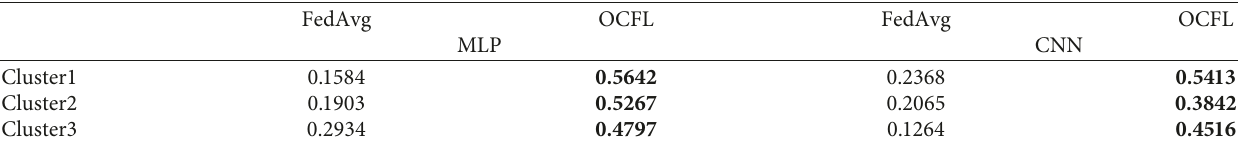
Figure 7: Cifar-10 data set clustering experiment (rounds � 500, η � 0.00001, frac � 0.1, (E) � 1, (B) � 10. Left is the result of MLP, right is the result of CNN). Table 4: Model test accuracy on